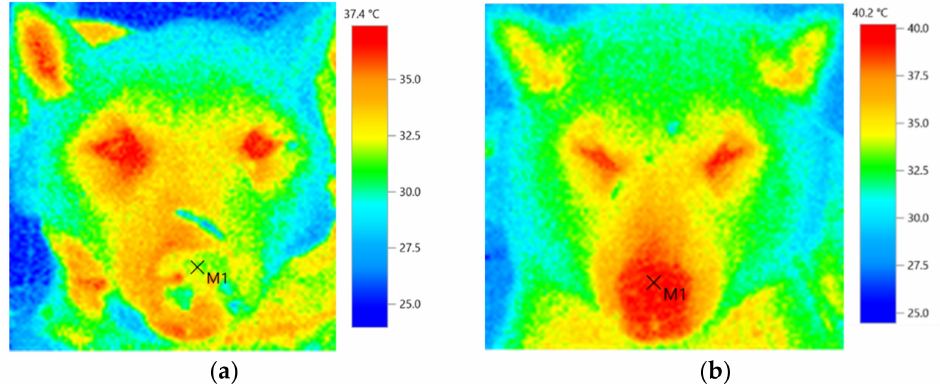
Figure 4. Thermal images before RT (( a ) before induction of anesthesia for RT) and after RT (( b ) 210 min after RT). M1 ( × ) was the target region used for thermographic analysis. Table 1. Ethogram for the patient relevant to radiation therapy. Behavior Operational Discription